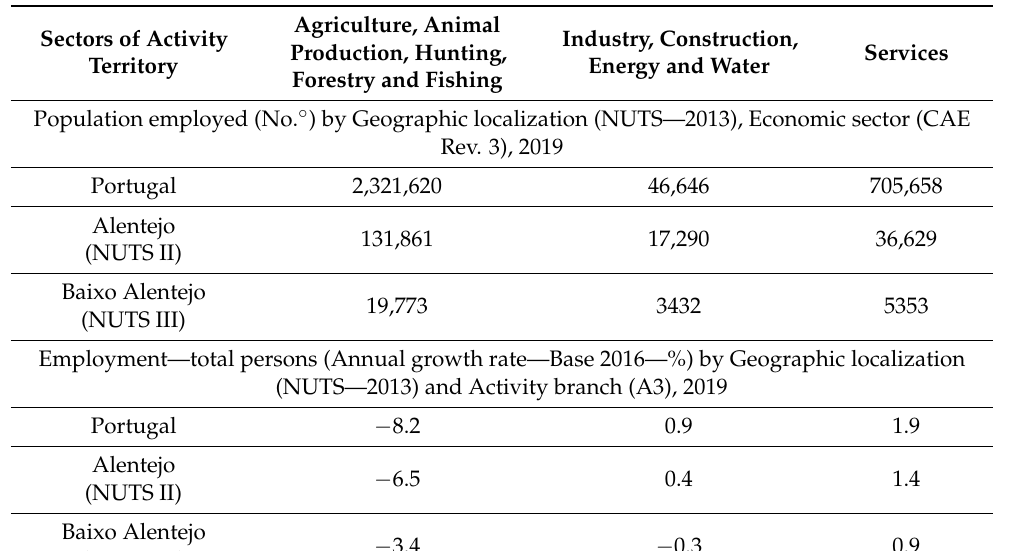
Table 2. Outlook on the employment by geographic localization (NUTS 2013) and activity branch. Source: INE